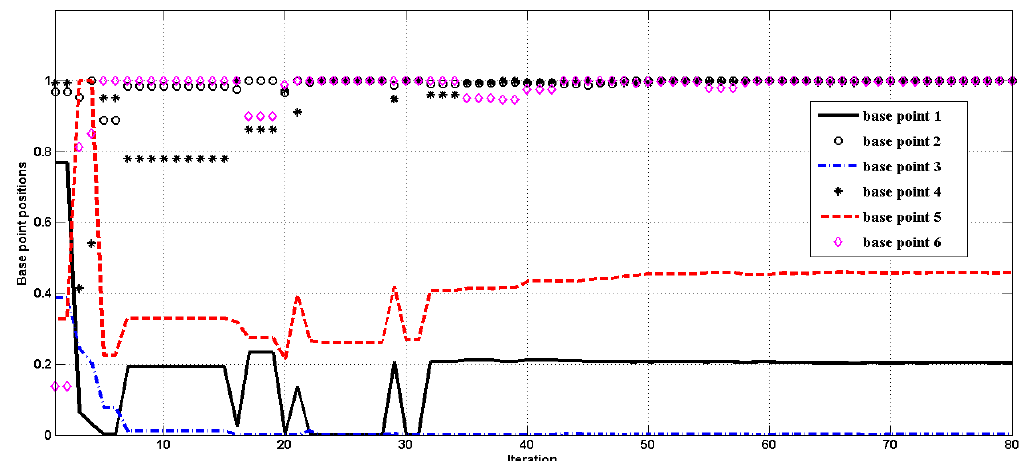
Figure 7. Maximum allowable dynamic wrench capability versus iteration number for base point locations being displaced individually.